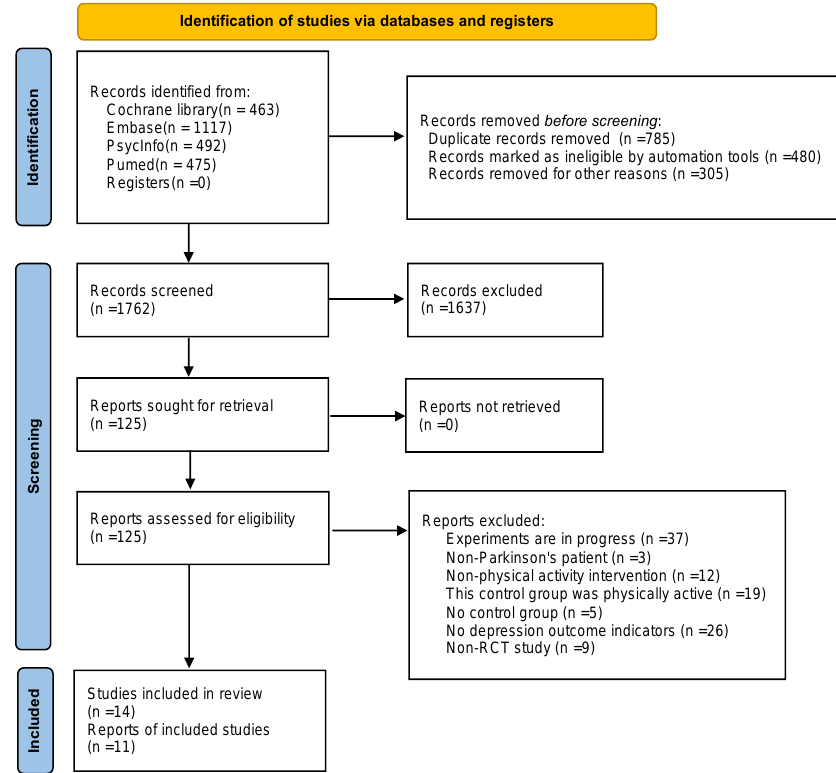
Figure 1. Flow chart with different phases of the search process. Table 1. Characteristics of the studies included in the study.